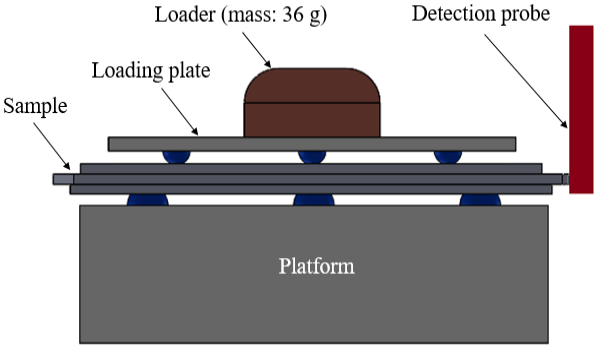
Figure 5. Steps in sample measurement: (a) placing the sample and IC tray on the jig; (b) applying a 36-g loading force to fix sample and (c) measuring the width with the probe.